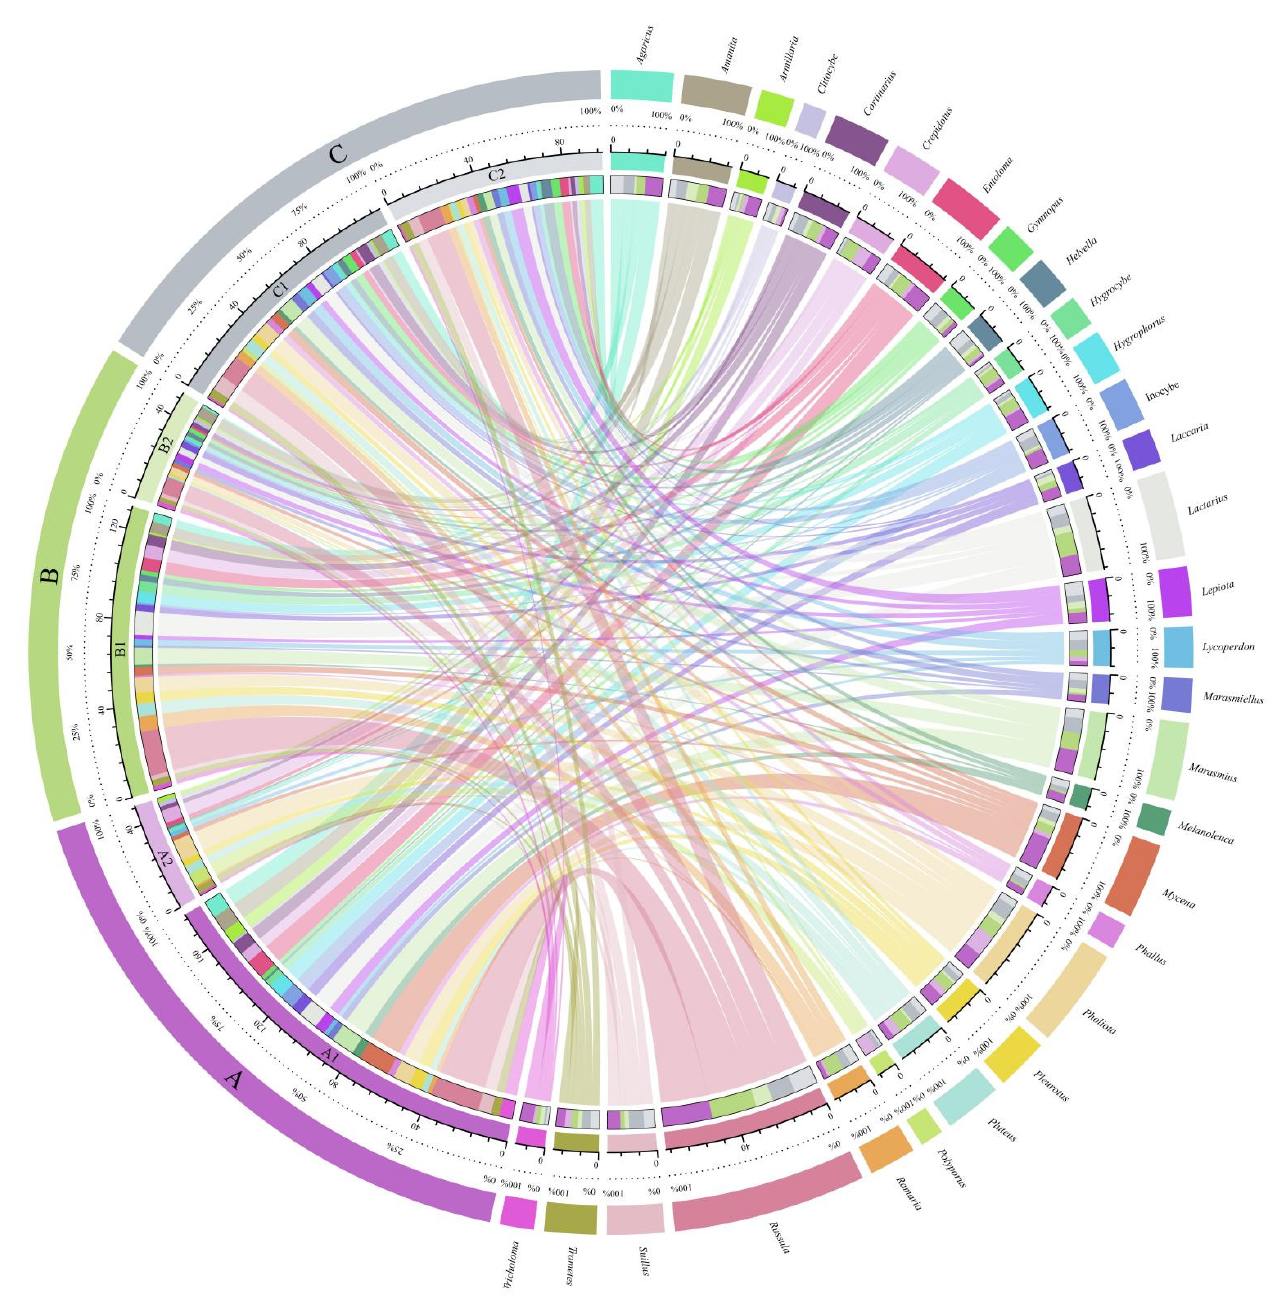
Figure 4. Circos plot shows the relative abundance of macrofungi in six different sites in Jinlin Prov- ince based on the genera with more than four species. The analysis of species abundance shows Russula was the common genus and site A1 contains more species than the other five investigation sites. A1: Quanshuidong Forest Farm; A2: Lushuihe National Forest Form; B1: Shengli River Forest Farm; B2: Longwan National Forest Park; C1: Zuojia Region; C2: Jingyuetan National Forest Park.